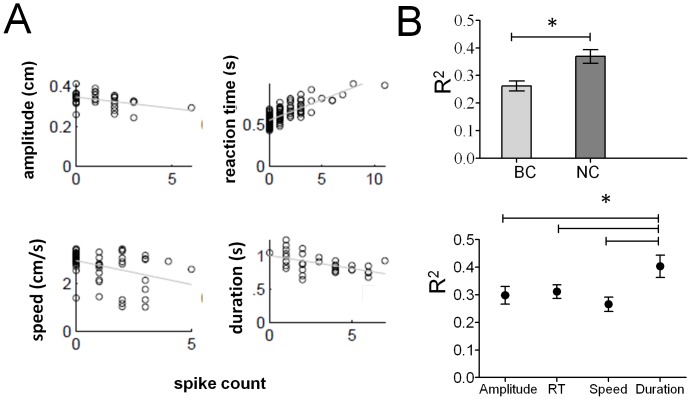
Correlations between the kinematic parameters of movement and the neural activity.(A) Magnitude of kinematic parameters (y-axis) plotted as a function of spike count for representative single neurons from the BC mode (x-axis). Each data point corresponds to a single trial and the line is a linear regression. (B) Coefficient of determination (R2) between the kinematic parameters and the numbers of spikes in the response window were different across modes (BC, NC) (top panel) and across kinematic parameters (bottom panel).